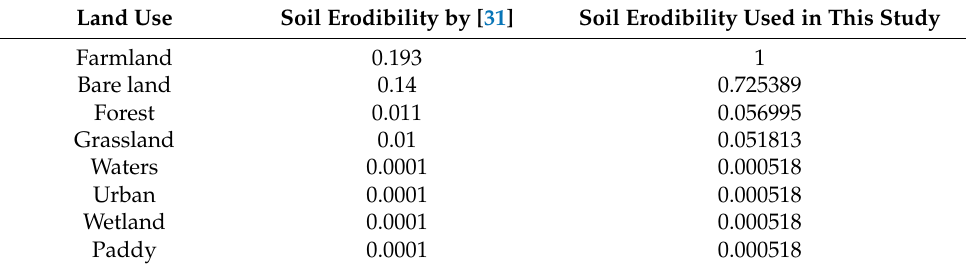
Table 1. Reclassified soil erodibility coefficients for land use in Korea.